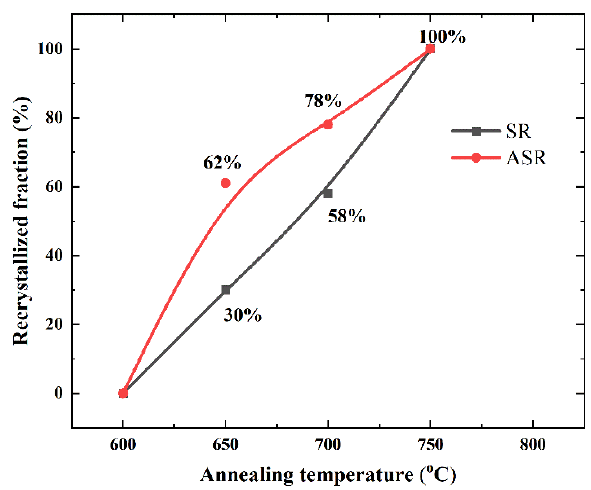
Figure 4. Recrystallized fraction as a function of annealing temperature. The black line is approximated to the nucleation speed at a specific recrystallization temperature.